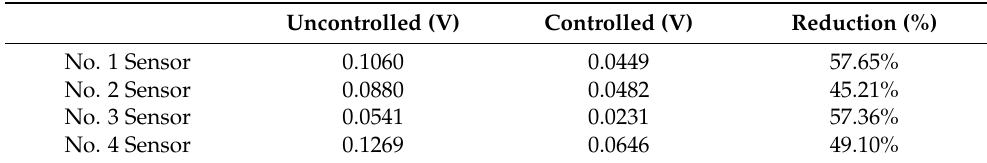
Table 2. Peak values of PSD curves of sensor signals: Simulation